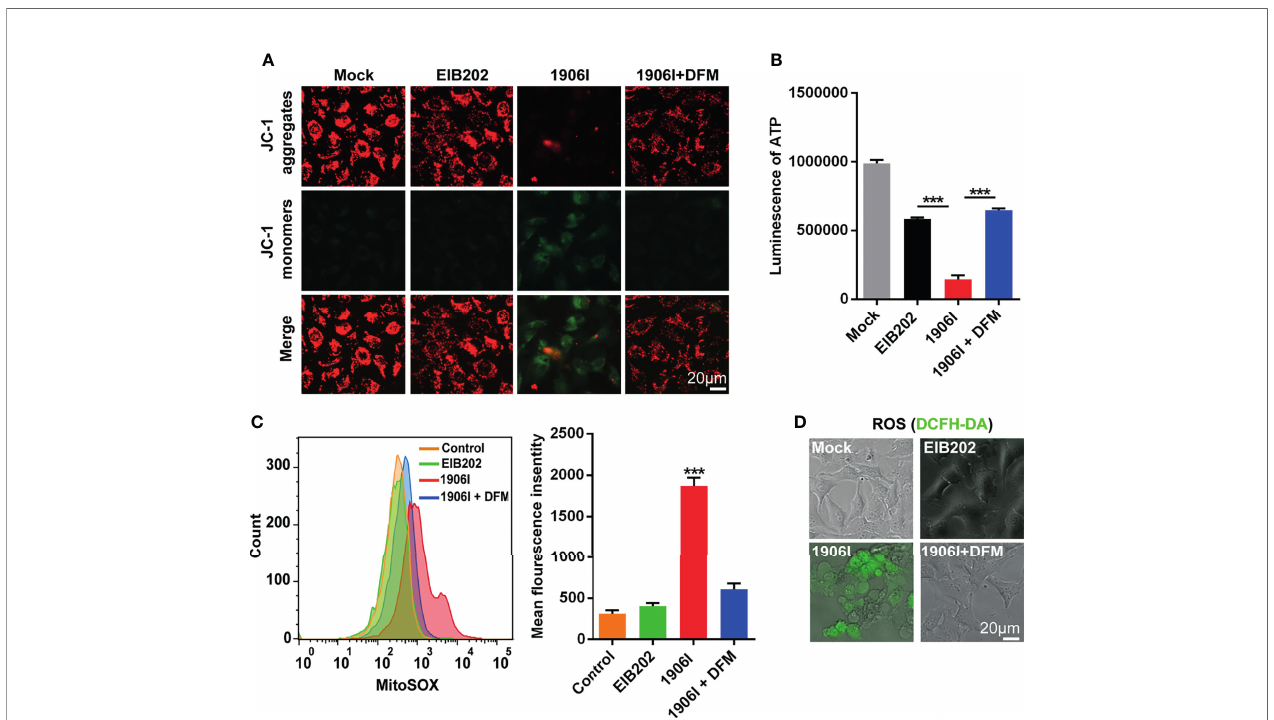
FIGURE 5 | Iron accumulation induced decrease of mitochondrial potential and ATP production and enhanced mitochondrial and cytosolic ROS generation. HeLa cells were infected with indicated E. piscicida strains at an MOI of 25 with or without DFM (50 µM). (A) Mitochondrial membrane potential ( DY m) of HeLa cells was detected by JC-1 staining and observed by fl uorescent microscopy at 3.5 h post bacterial infection. The double staining of cells by JC-1 is visible either as green for JC-1 monomers (low DY m) or red for JC-1 aggregates (high DY ). Scale bar, 20 m m. (B) ATP level of HeLa cells was measured by a luminescent ATP kit at 3.5 h post bacterial infection. (C) Flow cytometric detection of mitochondrial ROS by MitoSOX at 3.5 h post bacterial infection. (D) Determination of cellular ROS by DCFH- DA probe. Fluorescent microscopic images were taken at 3.5 h post bacterial infection. Scale bar, 20 m m. Results are representative of at least three independent experiments, and error bars denote SD of triplicate wells. *** P < 0.001 (One-way